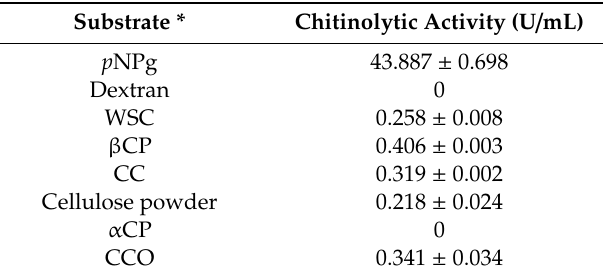
Table 3. Substrate specificity of TKU048 exochitinase.